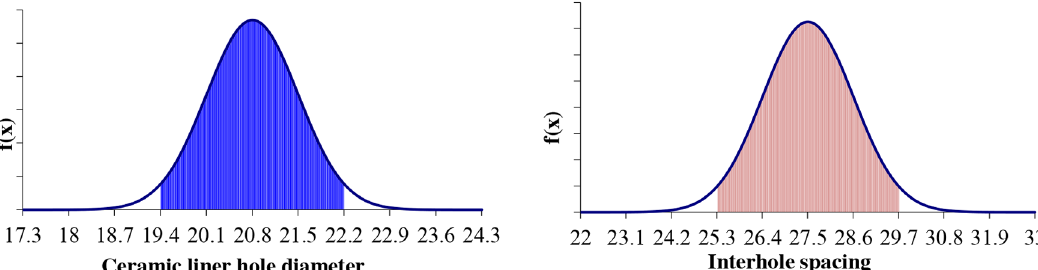
Fig. 4. Normal distribution showing 95.45% of observations in the range ( M